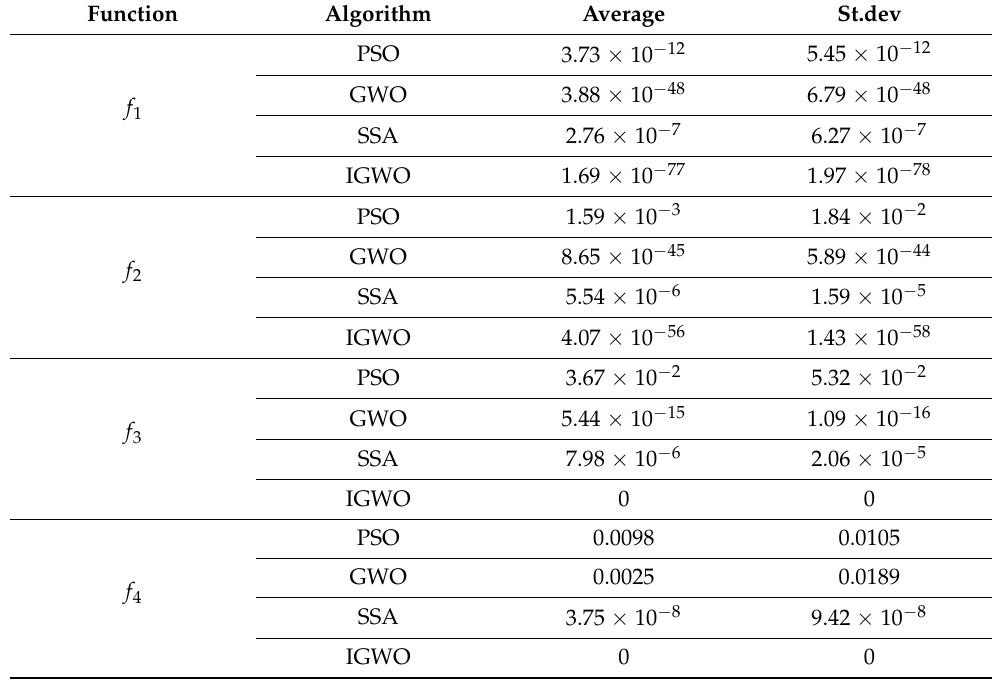
Table 3. Algorithm optimization